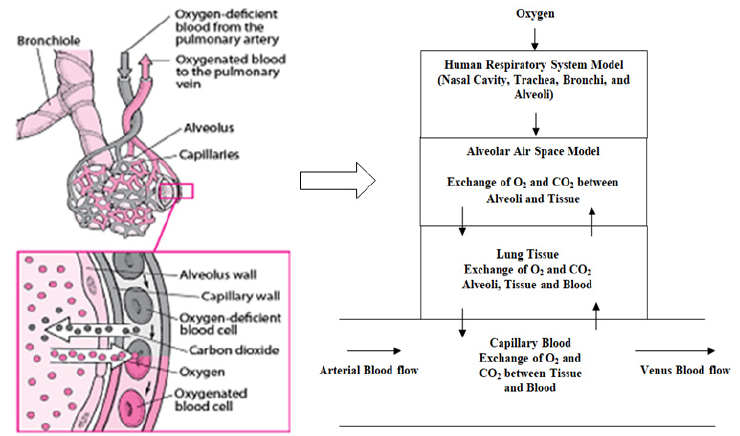
Figure 5. Schematic representation of the simple oxygen exchange model.